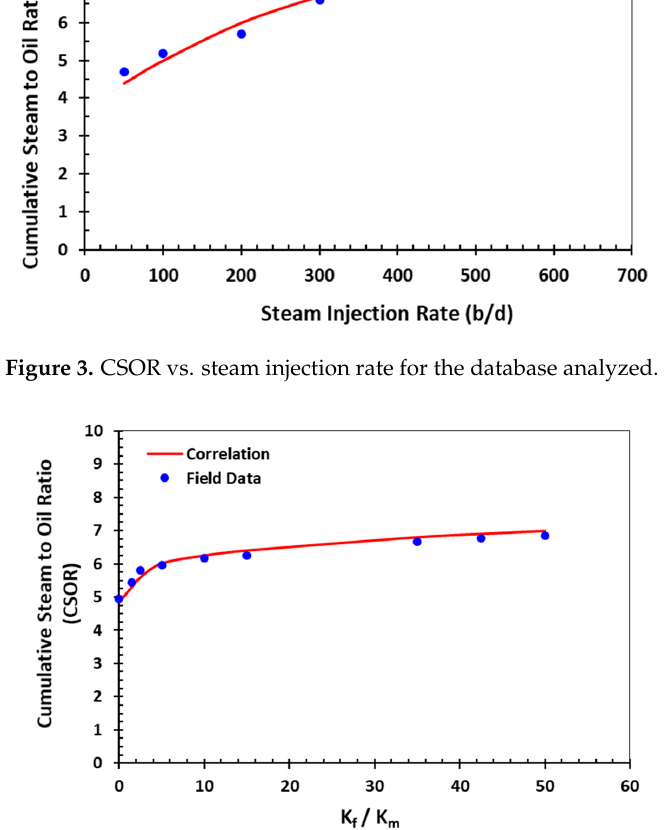
Figure 3. CSOR vs. fracture to matrix permeability ratio for the database analyzed. Figure 4. CSOR vs. fracture to matrix permeability ratio for the database analyzed.